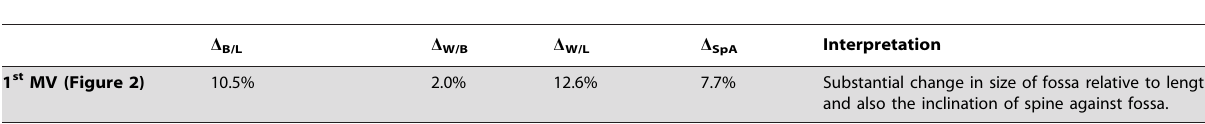
Table 1. Change rates of parameter values for the first MV in the ‘with size’ SSM.